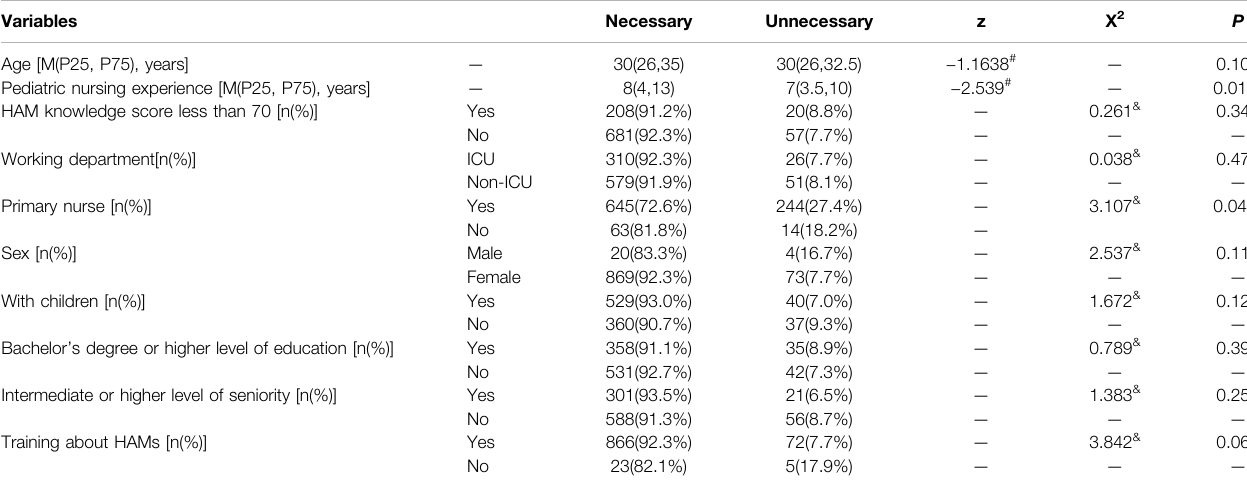
TABLE 4 | Level of decision support needs regarding HAMs (N =